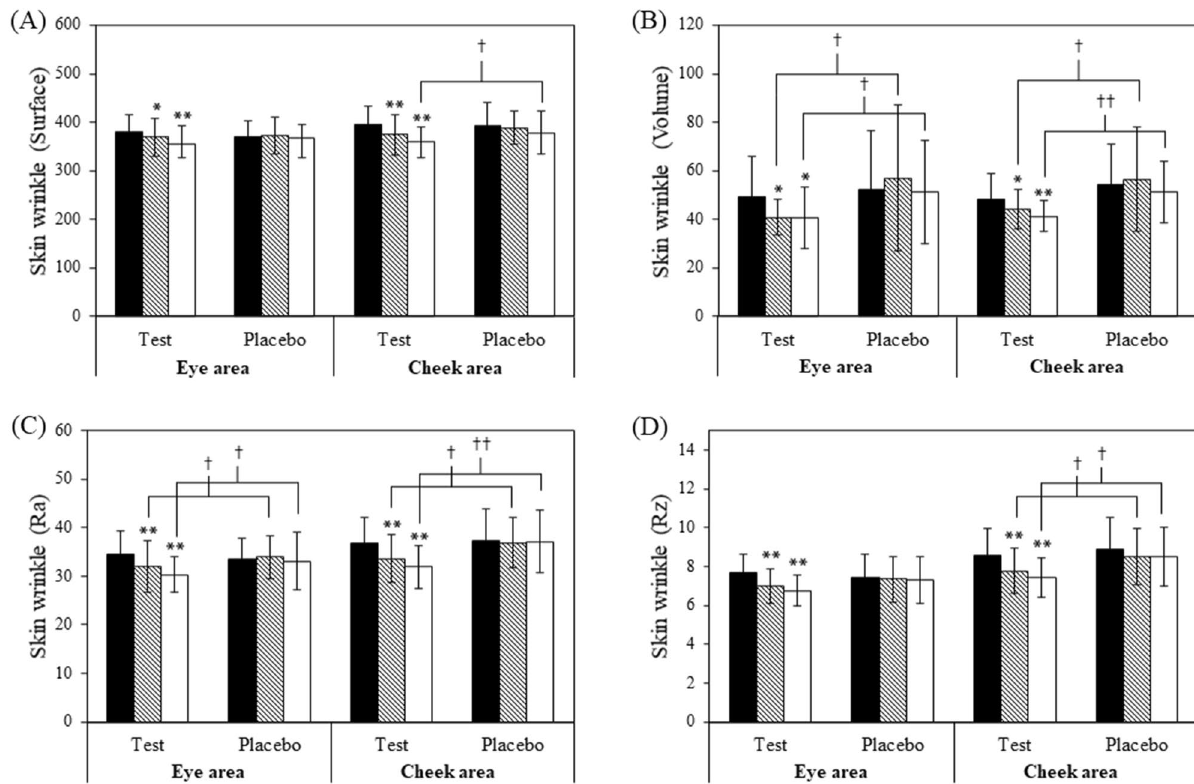
Figure 5. Skin wrinkle parameters, ( A ) surface; ( B ) Volume; ( C ) Ra; (D) Rz measured at two skin sites as the corner of eye and under cheek bone in the test and placebo groups at baseline ( ), after 30 d ( ) and 60 d (